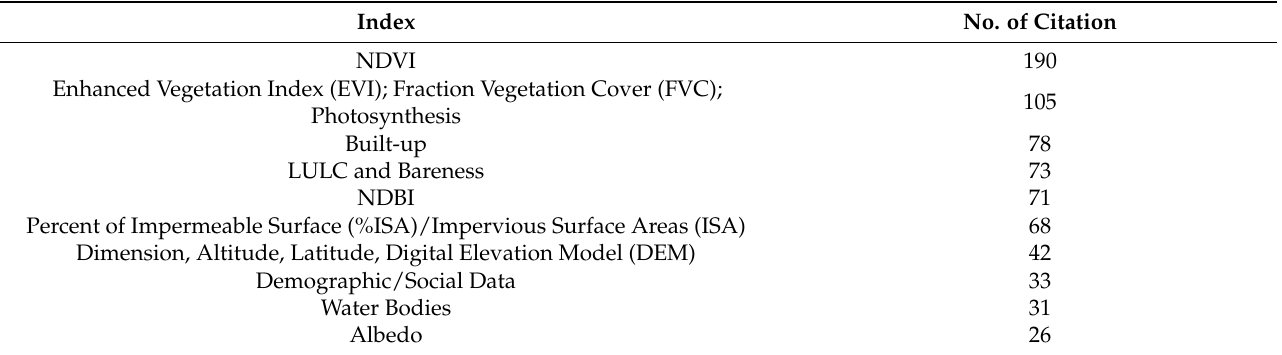
Table 9. Ten indices/indicators most